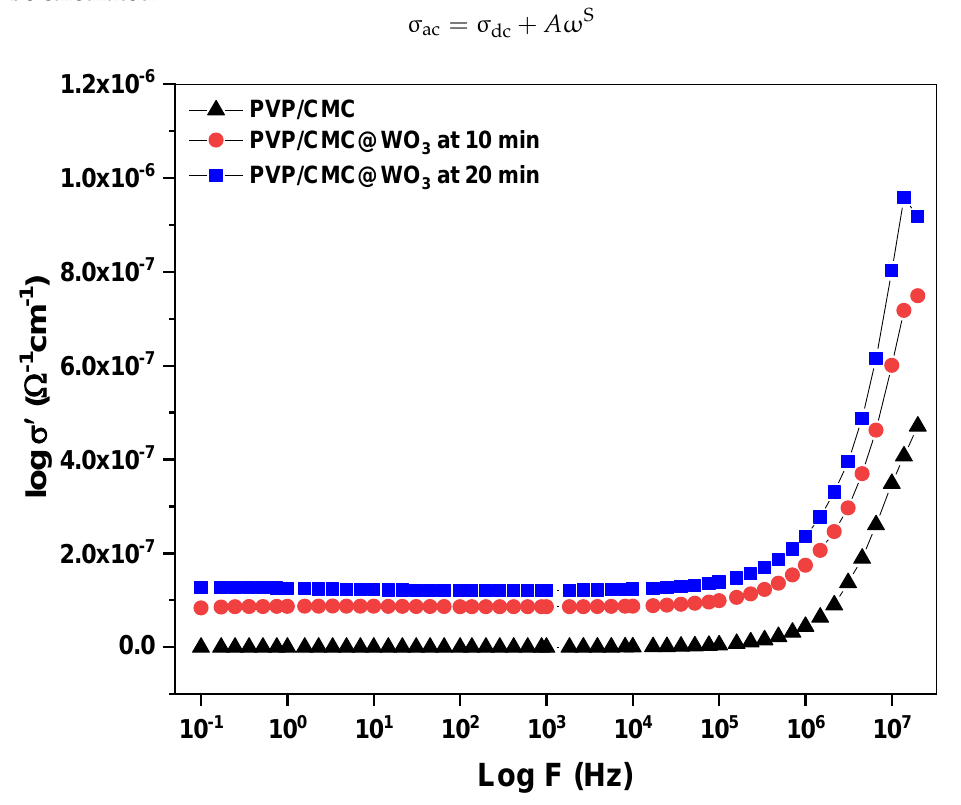
Figure 5. The difference of σ ac with the frequency for the PVP/CMC-WO 3 at two laser-ablation times (10 and 20 min).